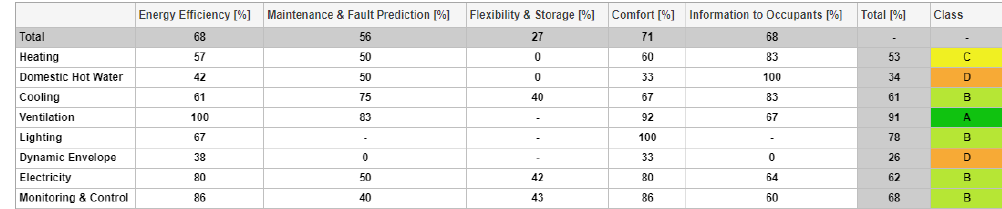
Figure 10. IBACSA performance matrix for Case C with domains and criteria impacts.